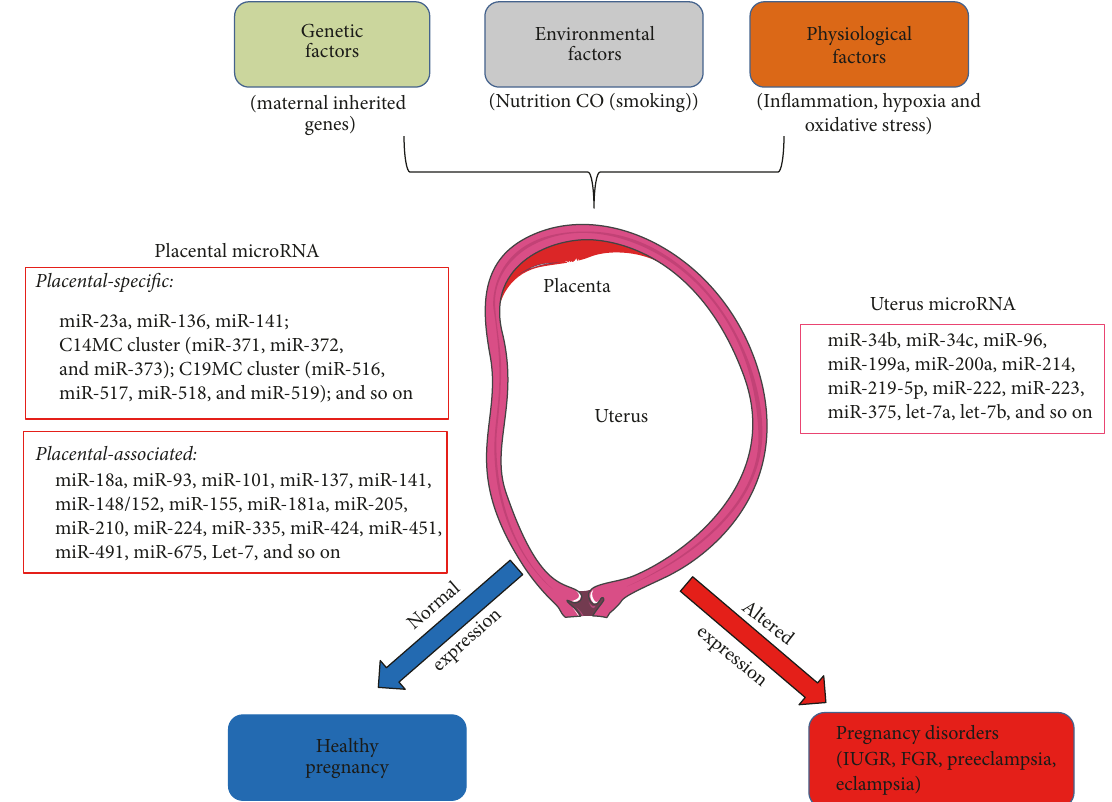
Figure2:Thepregnancyprocessisregulatedbygenetic,environmental,andphysiologicalfactors.MiRNAsintheplacentaanduterusrespond to the change of these factors during pregnancy. Altered expression of miRNAs leads to the pregnancy